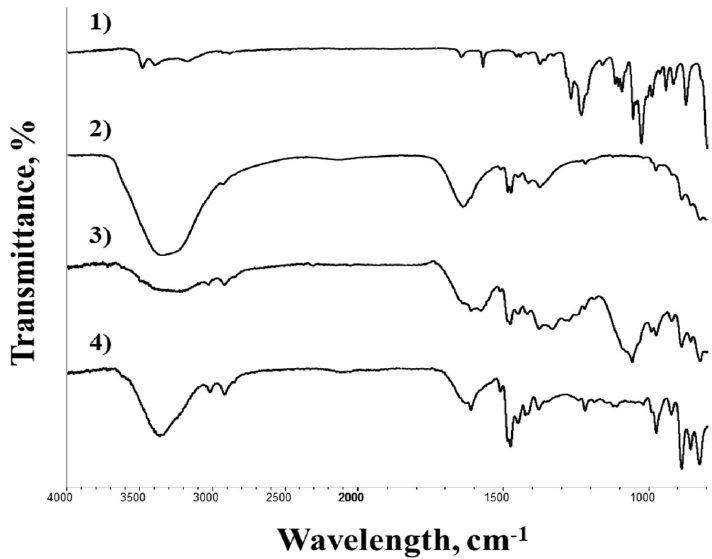
Figure 5. FTIR spectra of (1) standard of sinigrin (2) new PA312LOH resin before its use (3) resin after adsorption (4) resin after desorption.